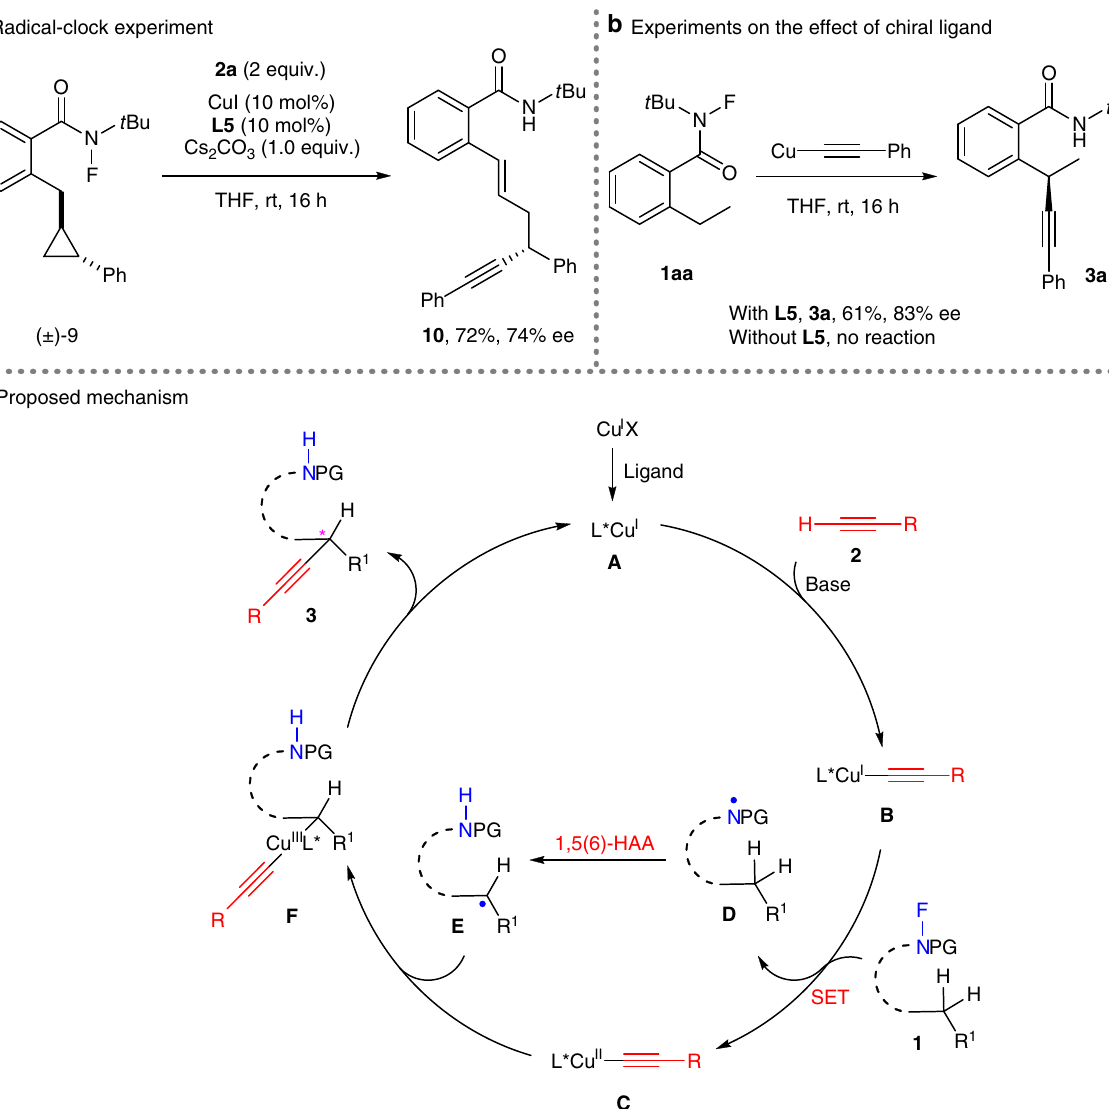
Fig. 5 Mechanistic investigations. a The radical-clock substrate (±)- 9 underwent ring opening before the C – C bond formation, thus indicating the initial generation of a benzylic radical. b The reaction of 1aa with copper acetylide did not occur in the absence of L5 , indicating that both chiral ligand and terminal alkyne are indispensable for reaction initiation. c The reaction was proposed to proceed through sequential single-electron reduction of substrate 1 , 1,5(6)-HAA, and copper-catalyzed C( sp 3 ) – C( sp )